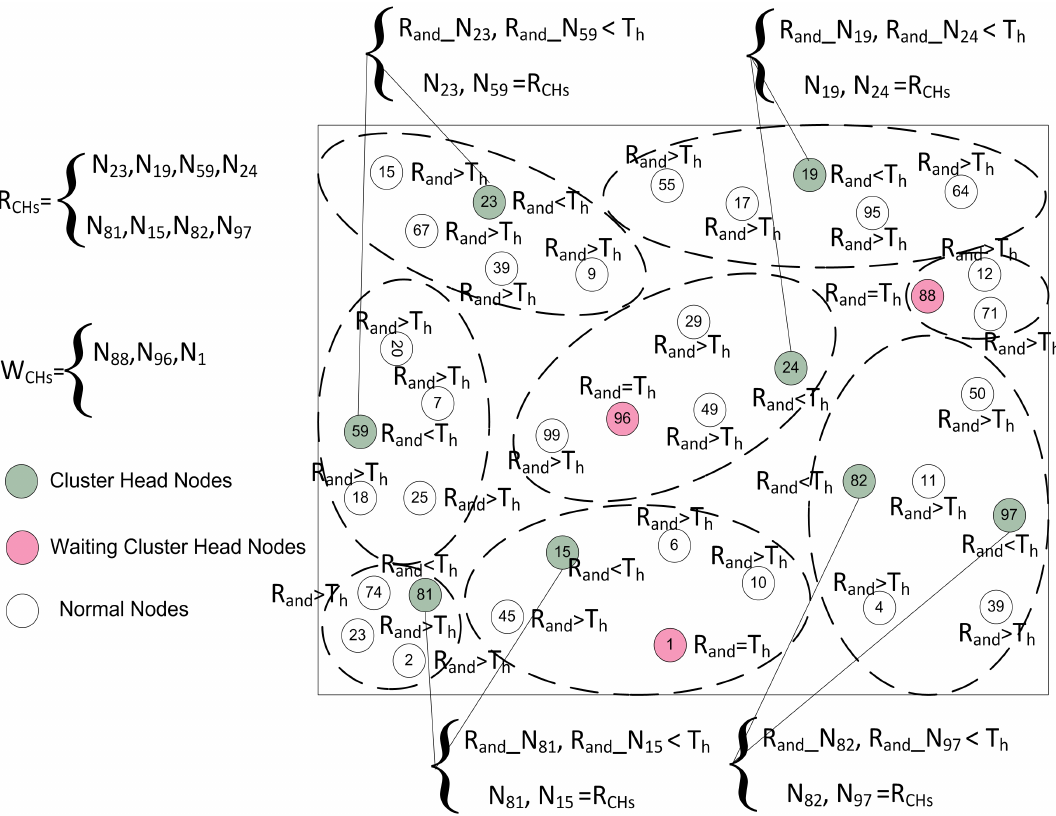
Figure 5. The random CH selection, and waiting for CH selection in the network on the basis of